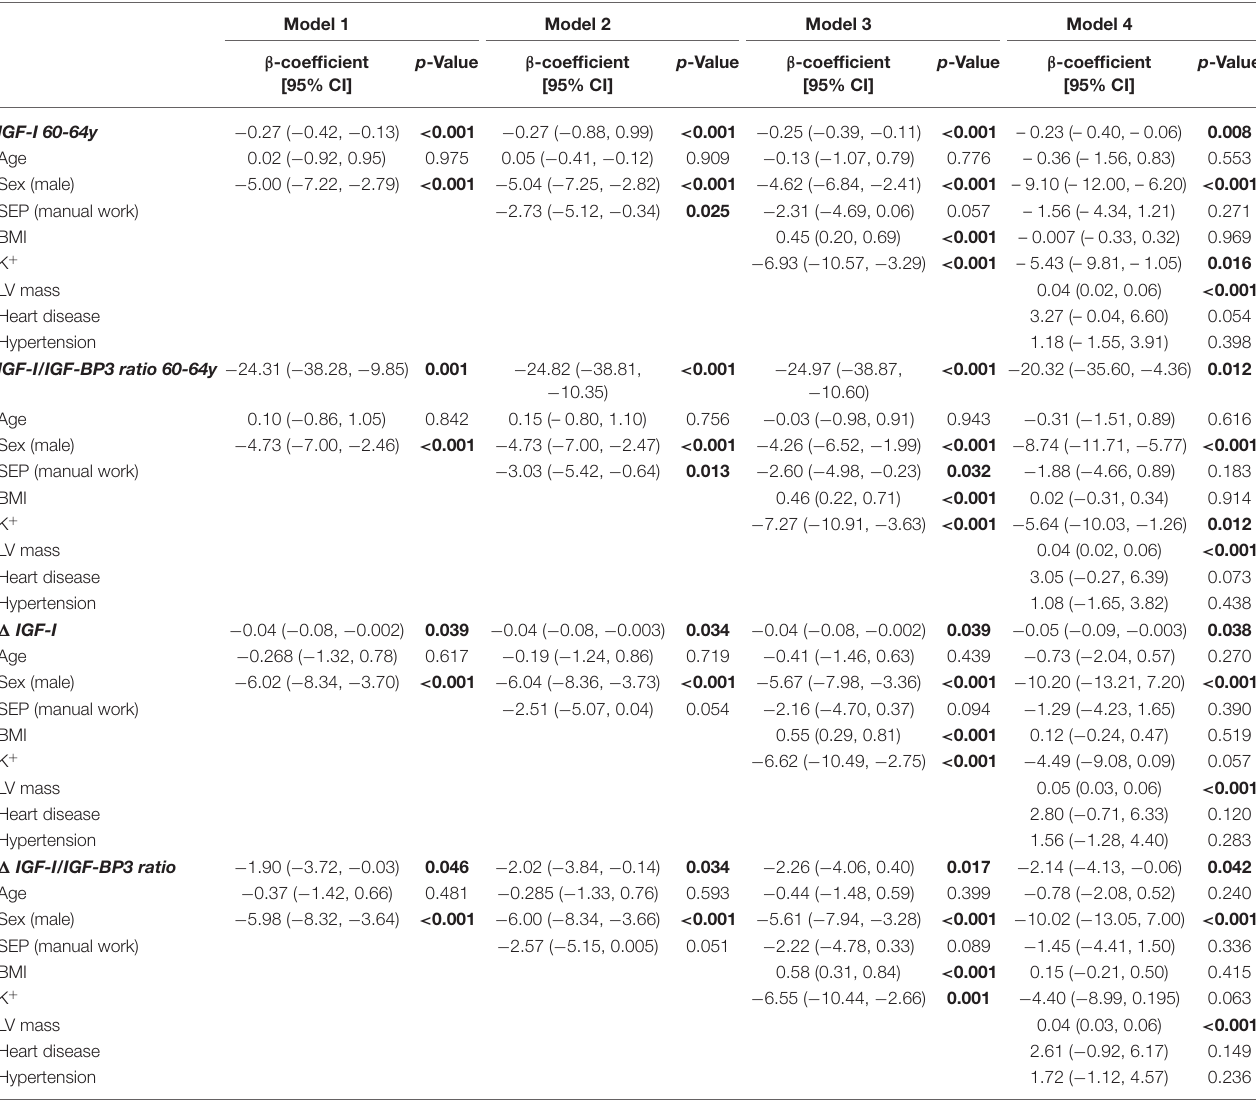
TABLE 4 | Multivariable regression (complete case analysis) for IGF-I at 60-64y, IGF-I/BP3 molar ratio at 60-64y, 1 IGF-I, 1 IGF-I/BP3 and exposures of interest with